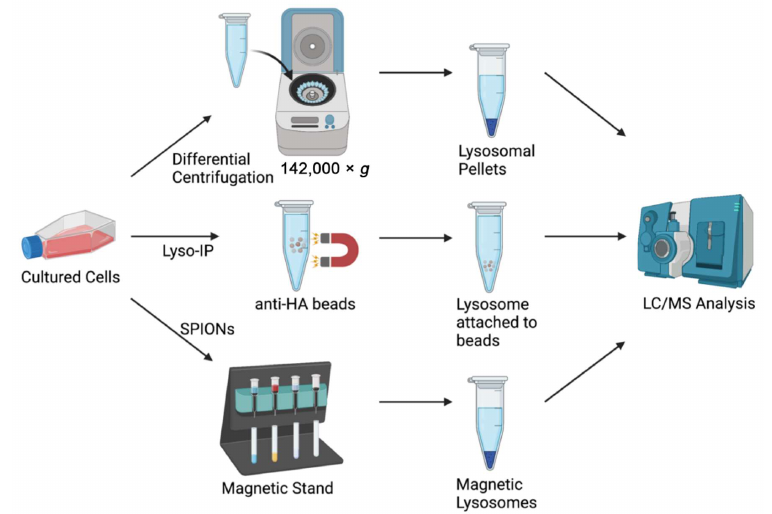
Figure 1. Widely used techniques for lysosome isolation include differential centrifugation (e.g., 142,000× g for 90 min), Lyso-IP (immunopurification of lysosomal transmembrane protein with cytosolic HA-tag), and SPIONs (magnetic isolation of DMSA-coated SPIONs). 4. Novel Insights into the Pathogenic Mechanisms of Niemann-Pick Type C Disease Revealed by the Lyso-IP Approach The application of the Lyso-IP approach to the field of LSD has uncovered critical insights into the mechanisms of lysosomal dysfunction in the LSD Niemann-Pick type C (NPC). NPC results from mutations in the NPC1 and NPC2 genes, which leads to the ac- cumulation of endocytosed intra-lysosomal cholesterol [39,40]. It was first noted that cho- lesterol, an essential building block for cellular growth, drives mTORC1 recruitment and activation at the lysosomal surface [22]. Additional studies completed in NPC-cellular models have shown mTORC1 is aberrantly hyperactive when NPC1 is knocked out [23]. To determine the mechanism underlying constitutive mTORC1 activation in NPC models, the protein composition of Lyso-IP lysosomes was analyzed by proteomic evaluations. This analysis identified oxysterol binding protein (OSBP) as the cholesterol carrier that delivers cholesterol across ER–lysosome contact points to the limiting membrane of lyso- somes, leading to mTORC1 activation [41]. In cells lacking NPC1, cholesterol accumulates both in the lysosomal lumen and by unopposed ER-to-lysosome transport via OSBP on the lysosomal membrane. In turn, excess lysosome-membrane cholesterol constitutively activates mTORC1 signaling and inhibits autophagy. When proteomic profiling of control and NPC-lysosomes was performed using the Lyso-IP approach, pronounced proteolytic impairment was documented for NPC lyso- somes, accompanied by hydrolase depletion, increased membrane micro-damage, accu- mulated autophagic adaptors, and defective mitophagy [23]. Importantly, it appears that hyperactive mTORC1 activity, rather than cholesterol buildup, is what drives these dys- functions because pharmacologic and genetic inhibition of mTORC1 was able to correct compositional and functional defects of NPC lysosomes while not altering cholesterol ac- cumulation. The restorative effects of mTORC1 inhibition on lysosomal function suggest